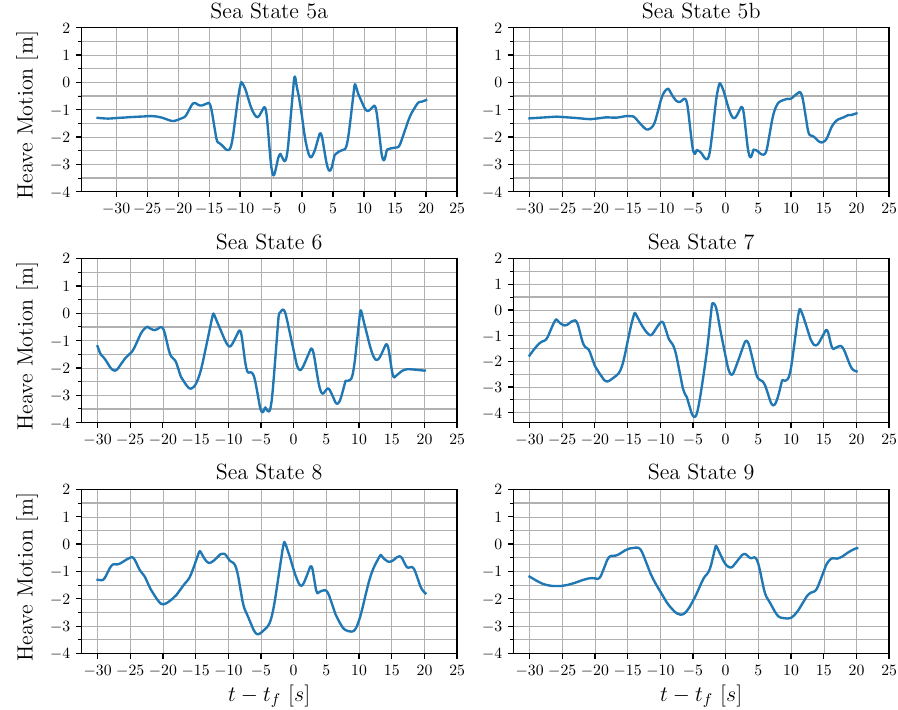
Figure 11. For all the examined sea states, the heave response time series during the wave–structure interaction is shown.